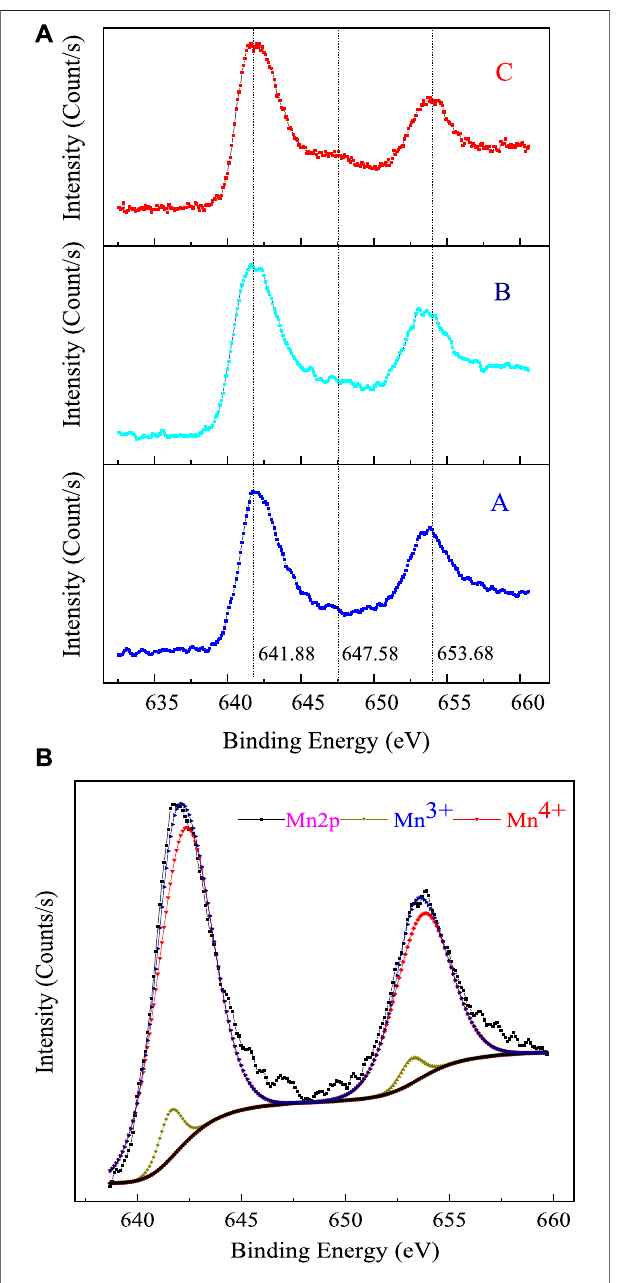
FIGURE 5 | XPS spectra of low-grade pyrolusite before and after microwaveheating (A) andthebest fi tofMn2pinrawpyrolusite (B) ;thebest fi t ofMn2pinmicrowavetreatedpyrolusiteat450 ° Cfor10 min (C) ;thebest fi tof Mn2p in microwave treated pyrolusite at 650 ° C for 50 min (D) .